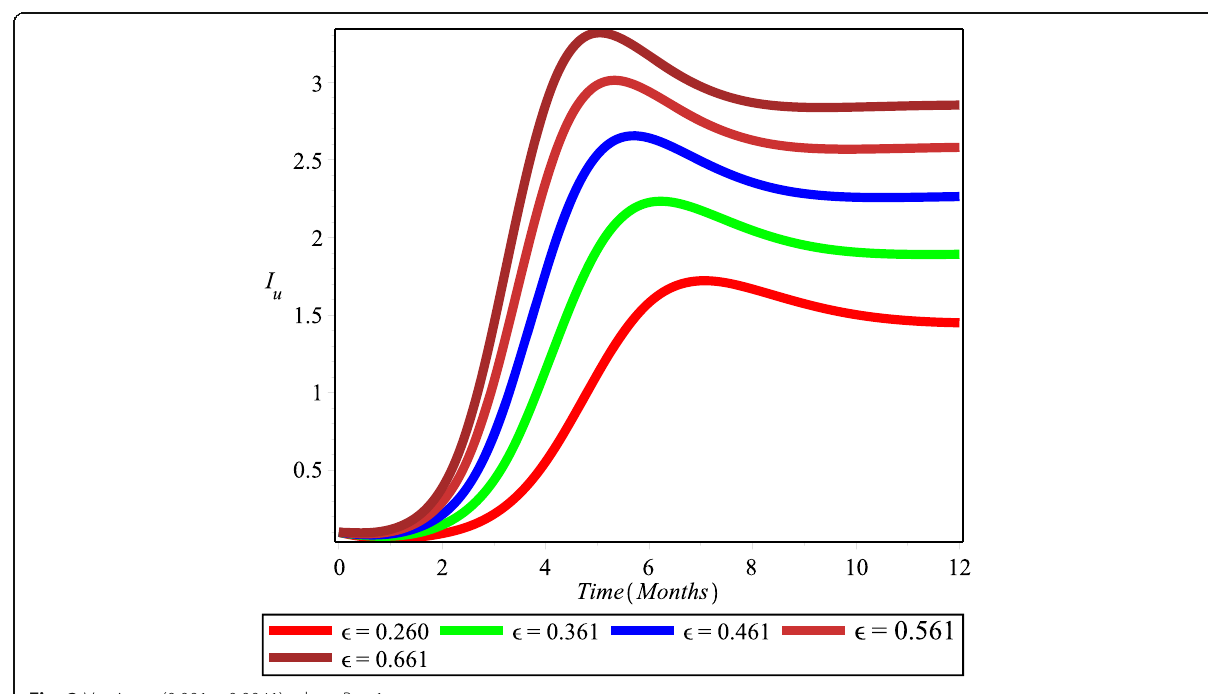
Fig. 2 Varying ϵ (0.001 − 0.0041) when R r <